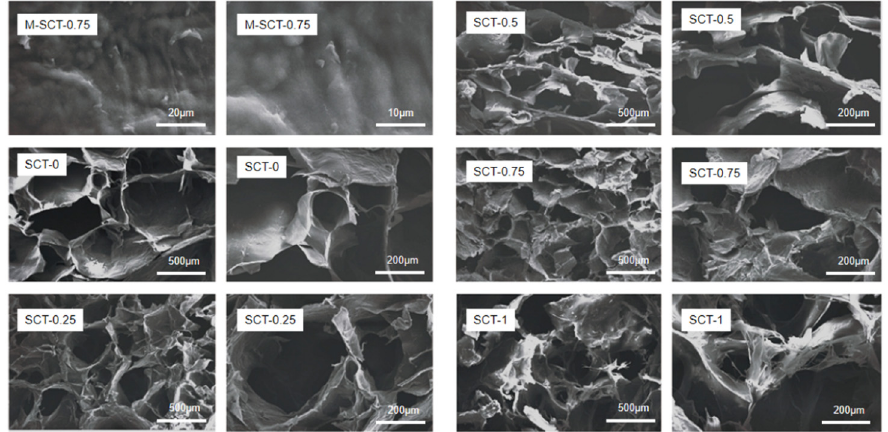
Figure 4. Addition of excess STPP can lead to hollowing inside the hydrogel. SEM images of the surface microstructures of M-SCT-0.75 hydrogels and SEM images for SCTs’ hydrogels with different STPP